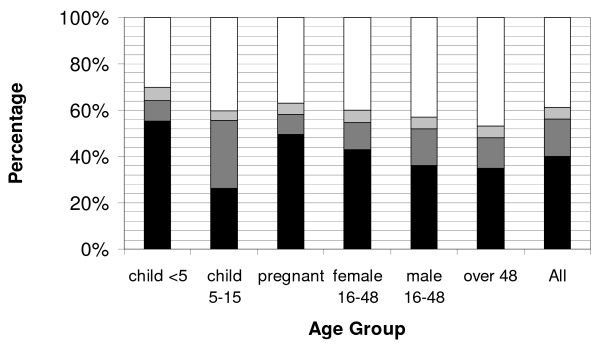
Age specific breakdown of individuals in each of the four ITN use categories during rainy season following an integrated campaign targeting children <5 years of age in Sierra Leone. Denominator includes all persons in respective age group. ITN use categories are: white: living in households with no ITN present; light grey: living in households owning but not hanging an ITN; dark grey: living in households that have an ITN hanging but are not sleeping under an ITN; and black: sleeping under an ITN. Female 16-48 includes non-pregnant women of reproductive age.